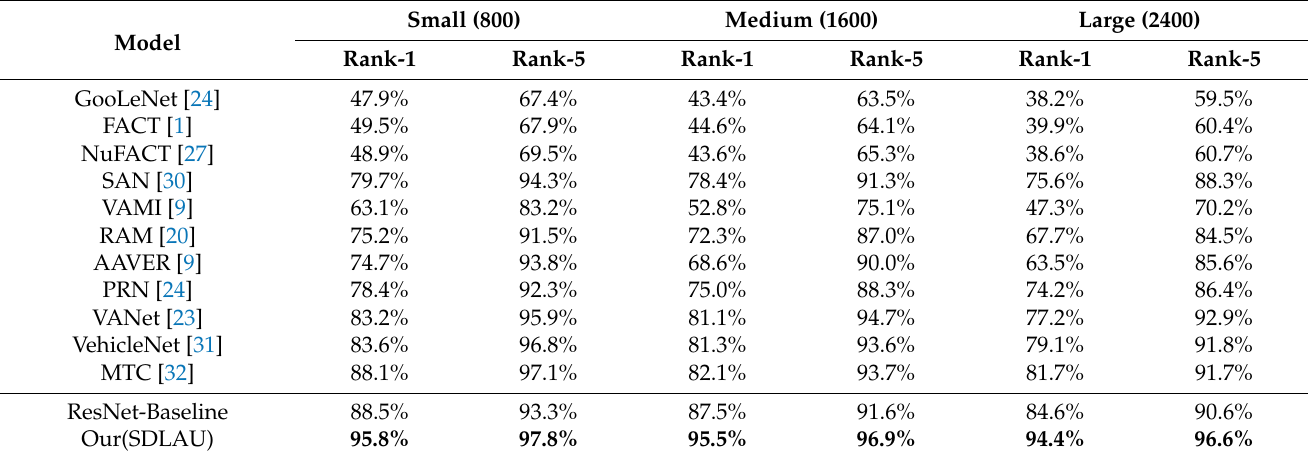
Table 4. Comparison results with the most advanced methods on the VehicleID